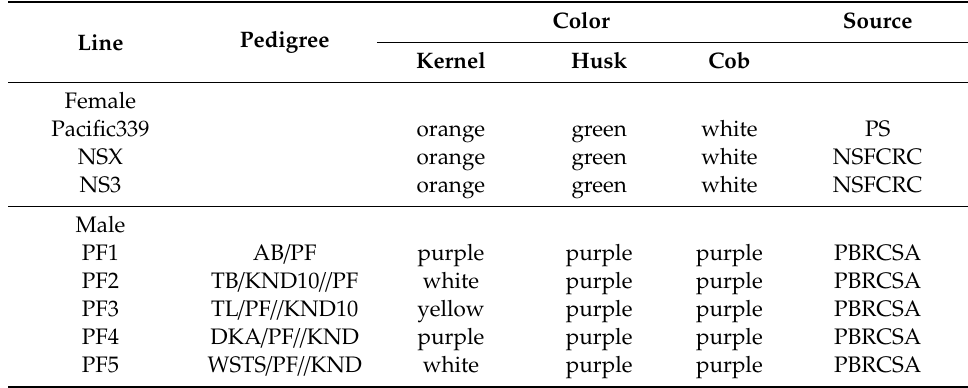
Table 1. Brief information of field corn genotypes used in this